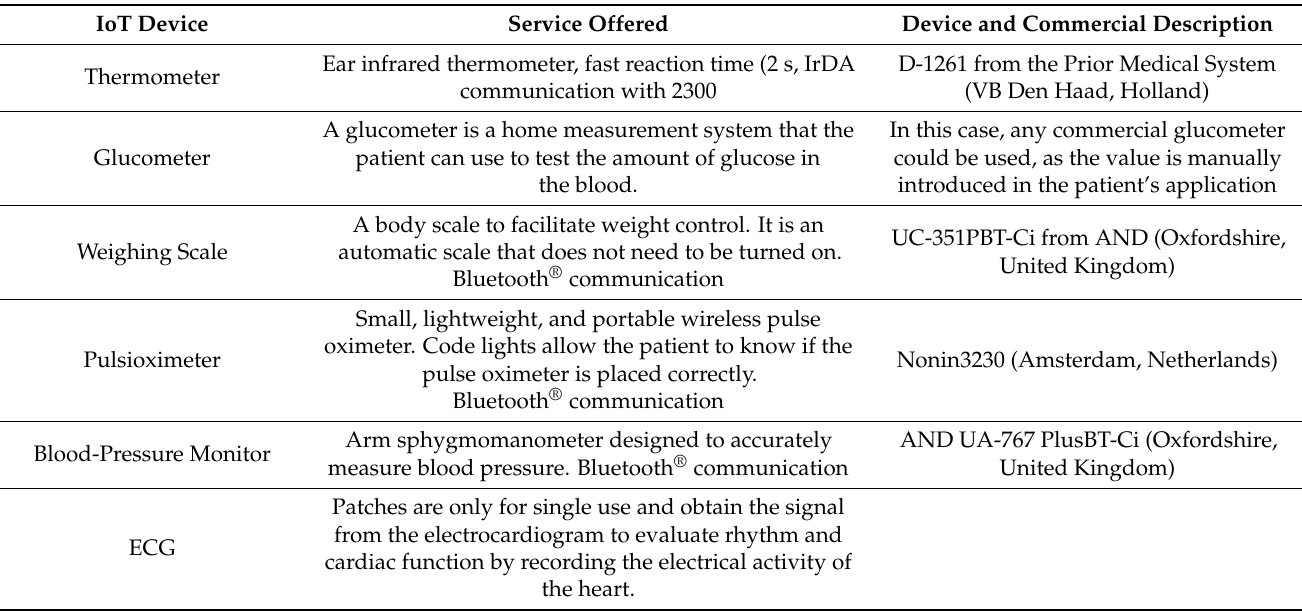
Table 1. Devices based on the